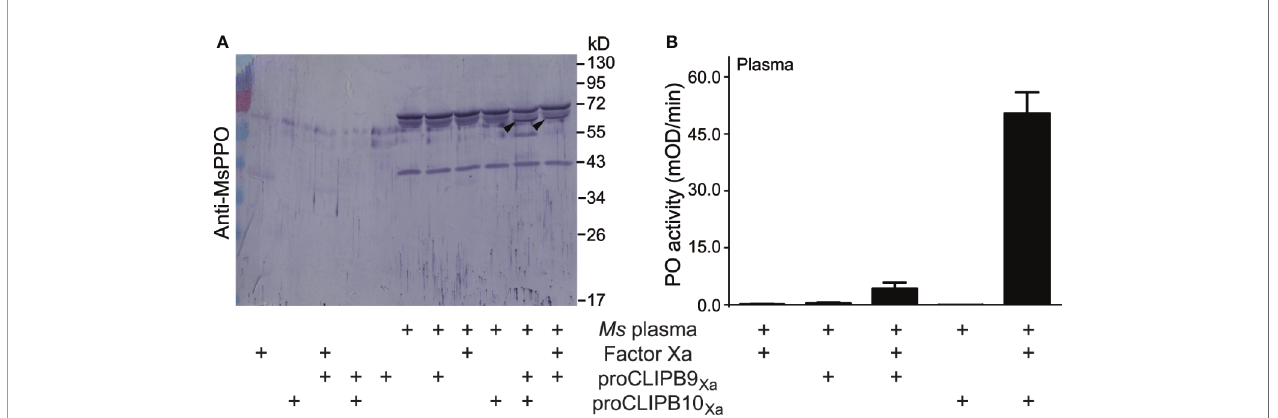
FIGURE 3 | Plasma proPO is cleaved and activated by active rCLIPB10 Xa . (A) Puri fi ed recombinant proCLIPB9 Xa or proCLIPB10 Xa were activated by Factor Xa, and was added individually to M. sexta plasma. The Western blot of the reactions was probed with anti- M. sexta PPO antibody. Black arrows indicate the band that correspond to M. sexta PO. (B) PO activity was observed when plasma was supplemented with activated CLIPB9 Xa or CLIPB10 Xa . Data are shown as means ± S.D (n = 6).